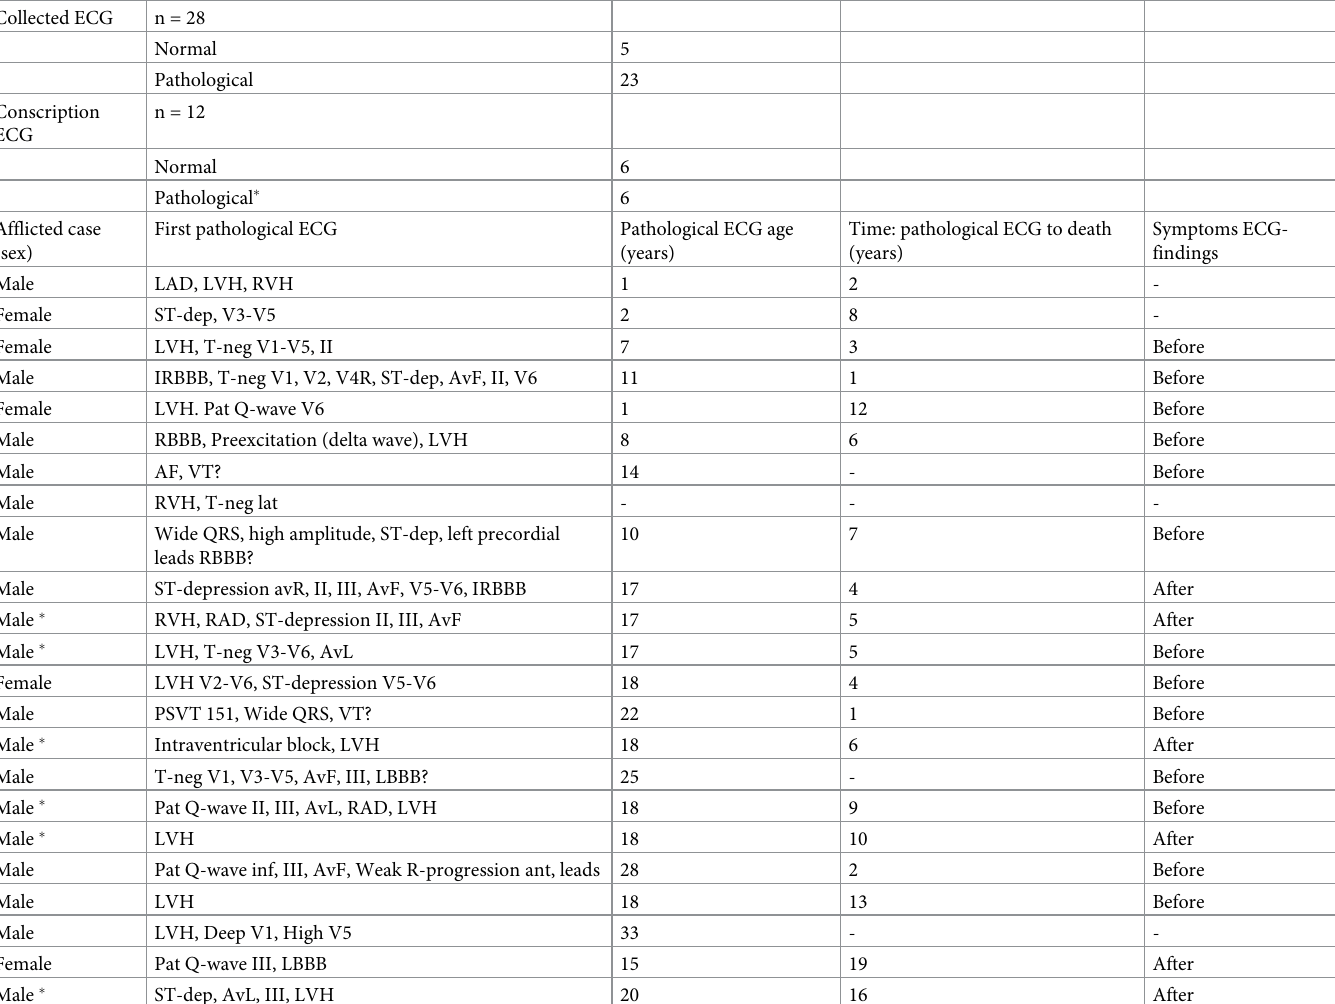
ST-dep, AvL, III, LVH LAD, Left Axis Deviation; RAD, Right Axis Deviation; LVH, Left Ventricle Hypertrophy; LBBB, Left Bundle Branch Block; RBBB, Right Bundle Branch Block; AF, Atrial Fibrillation; VT, Ventricular Tachycardia; IRBBB, Incomplete Right Bundle Branch Block; PSVT, Paroxysmal Supraventricular Tachycardia; Dep, Depression; Ant, Anterior; Lat, Lateral; Inf, Inferior. � Pathological ECG at